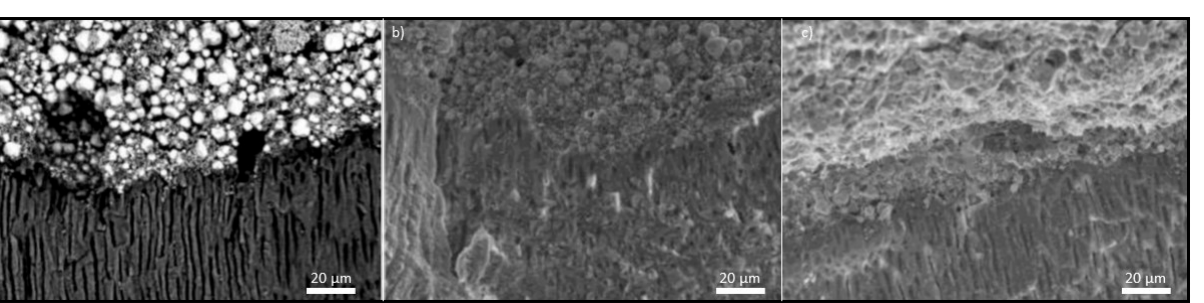
Figure 13. Lateral tubules in the research material subjected to decalcification, viewed with LSM: ( a ) in the apical part of the root canal, filled in the direction from the root apex, successively—the first with a sealant, the second with a gutta- percha substitute material centrally and centrifugally with a sealant, and the third with a gutta-percha substitute material;